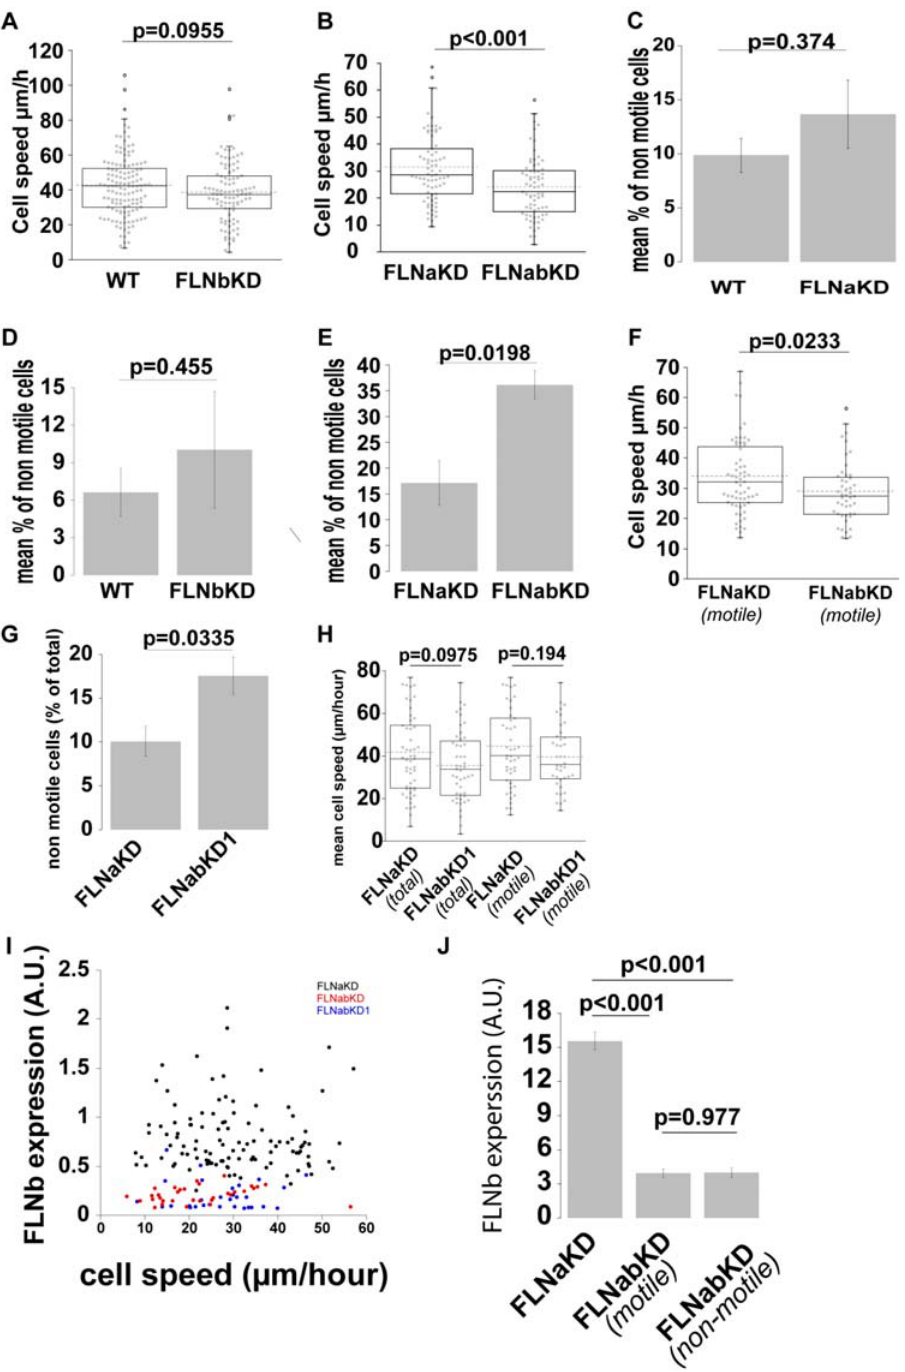
Figure 5. FLNs play a role in initiation of cell migration. A,B,F and H ) Speed of HT1080 WT and FLNbKD (A), FLNaKD and FLNabKD (B), FLNaKD(motile) and FLNabKD(motile) (F), or FLNaKD and FLNabKD1 (H) were compared in time-lapse migration assays. Dot plot shows the overall population distribution (sample size: WT=137; FLNbKD=99; FLNaKD=74 in B and 53 in H; FLNabKD=71; FLNabKD1=48; at least 4 independent experiments were performed for each pair), dotted line shows the mean value, box and whiskers plots show quartiles. C,D,E and G ) % of non motile cells in the time lapse experiments expressed as mean 6 SEM. I ) relation between cell speed and FLNb expression in FLNaKD (black dots), FLNabKD (red dots) and FLNabKD1 (blue dots). J ) FLNb content of FLNaKD, FLNabKD motile and FLNabKD non-motile cells. Total fluorescence of FLNb staining was measured at the end of time-lapse recording.Bars show mean value 6 SEM (sample size: FLNaKD=58; FLNabKDmotile=22; FLNabKDnon-motile=15 from 3 independent experiments). doi:10.1371/journal.pone.0007830.g005 (Figure 5H). Exclusion of non-motile cells from the analysis Analysis of FLNabKD1 cells also revealed a significant increase in resulted in further convergence of mean speed of the motile the percentage of non-motile cells (Figure 5G), but in this case the FLNaKD and FLNabKD1 populations (Figure 5H). Comparison reduction in mean cell speed was not statistically significant